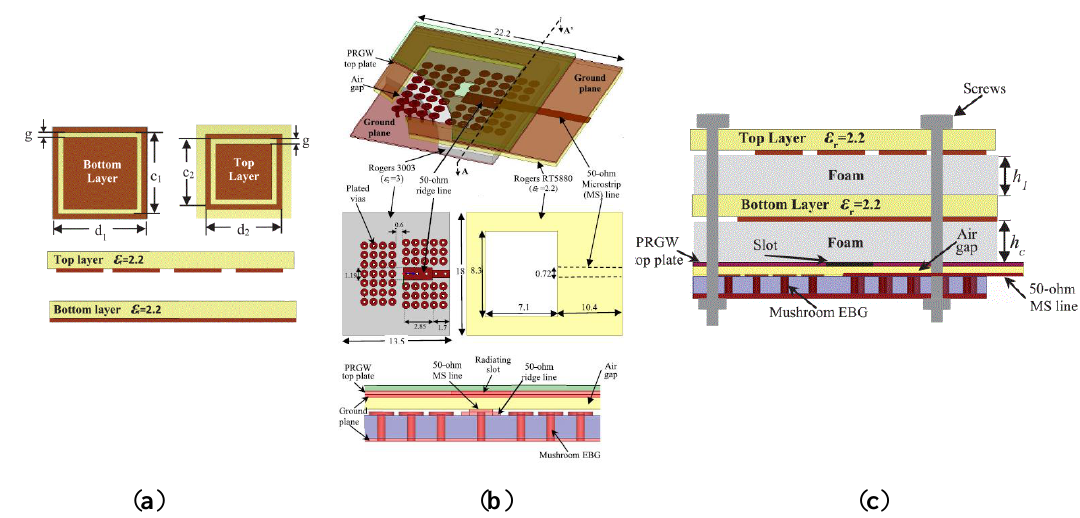
Figure 1. Configuration of a wideband RCA along with a PRS with positive reflection phase: ( a ) Unit cell of PRS; ( b ) Main radiating element (PRGW); ( c ) Entire structure [65].